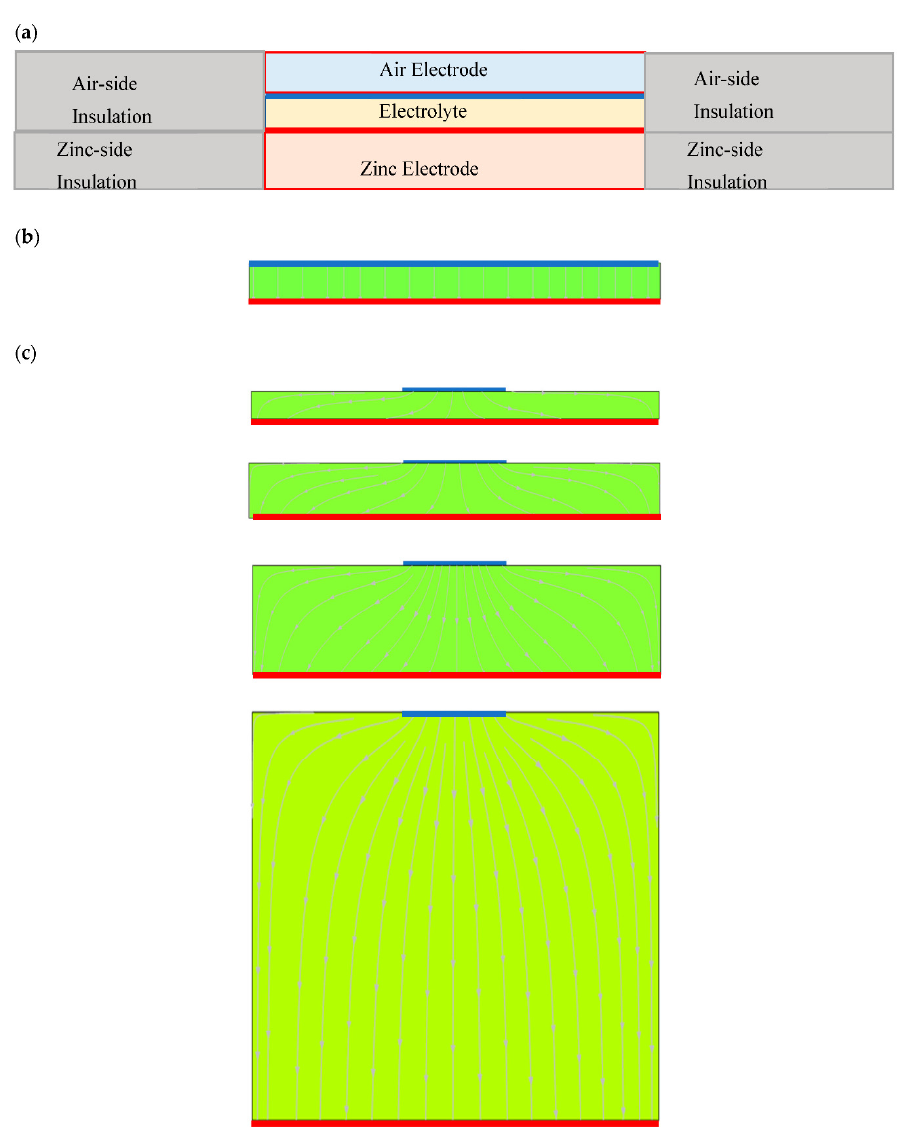
Figure 4. Components of cell cross-sections used for computer modeling. ( a ) Configuration of Cells 1 and 2 used for modeling. ( b ) Streamline of current flow of Cell 1 and 2. ( c ) Cell 3 and 4 used for modeling with different anode/cathode distances (2, 4, 8, and 30 mm). The streamline arrows denote current flow in the electrolyte.